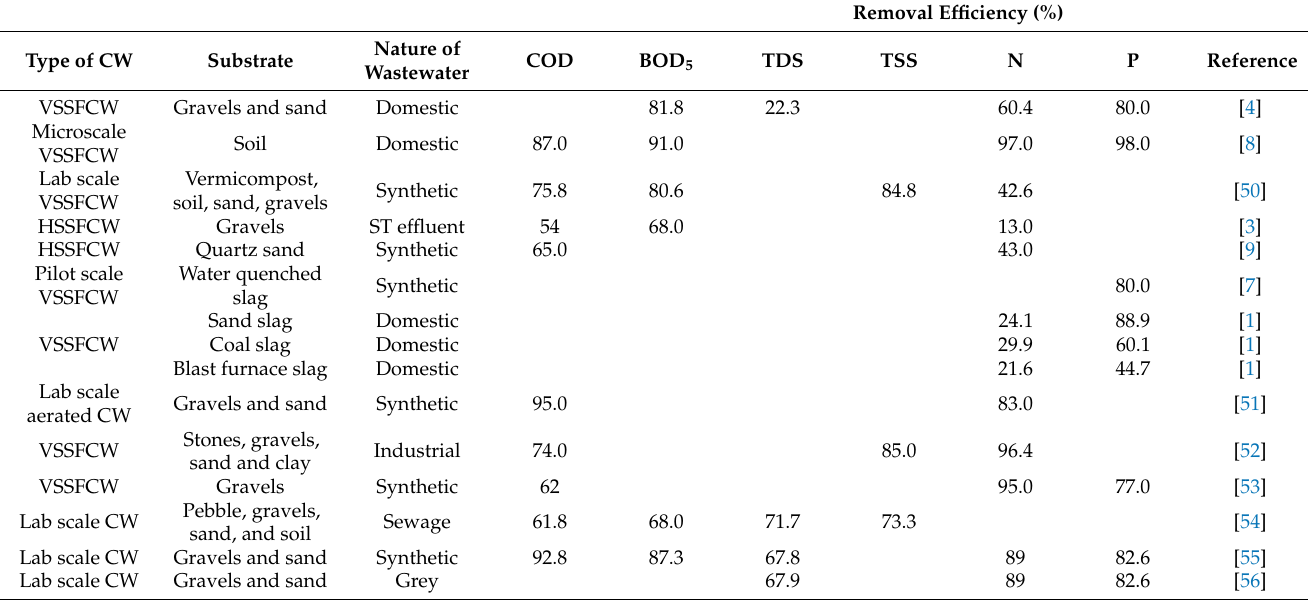
Table 2. Examples of studies on performance of CW planted with Canna indica in treatment of